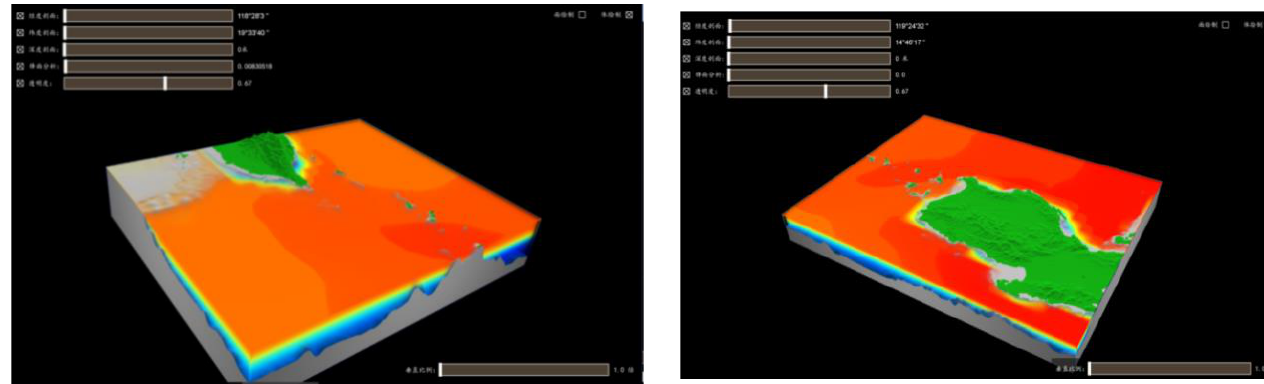
Figure 13. Volume visualization.